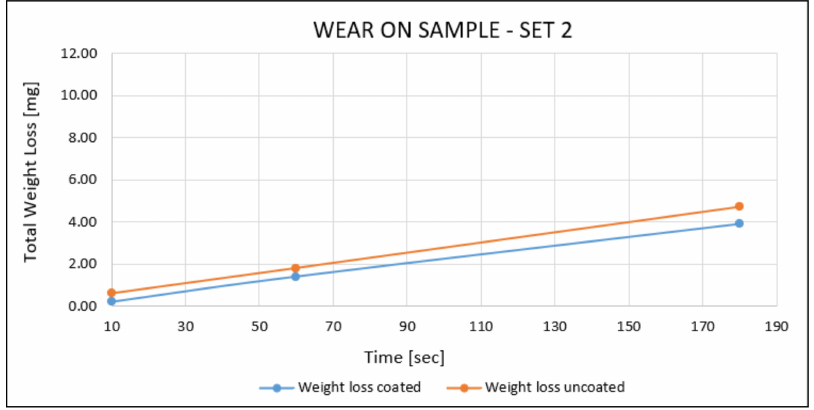
Figure 16. Wear results on the sample—set